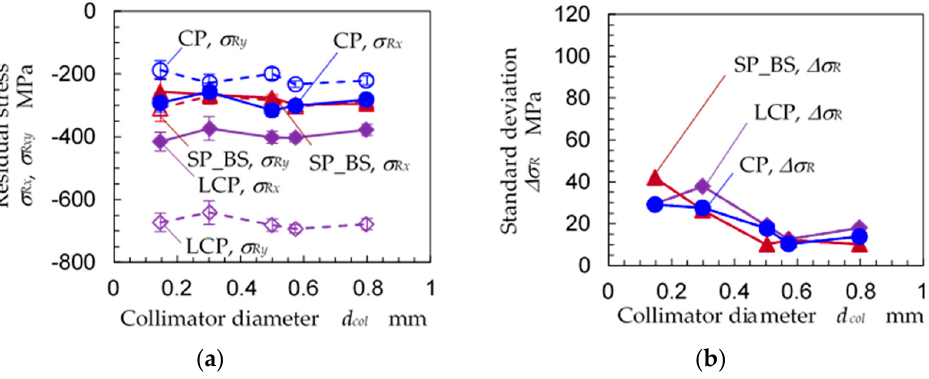
Figure 12. Effect of the collimator dimeter on the residual stress measurement of the stainless steel by the 2D method ( ∆ ω = 8°); CP: specimen A, LCP: specimen B, SP_BS: specimen C. ( a ) residual stress; ( b ) standard deviation of residual stress.